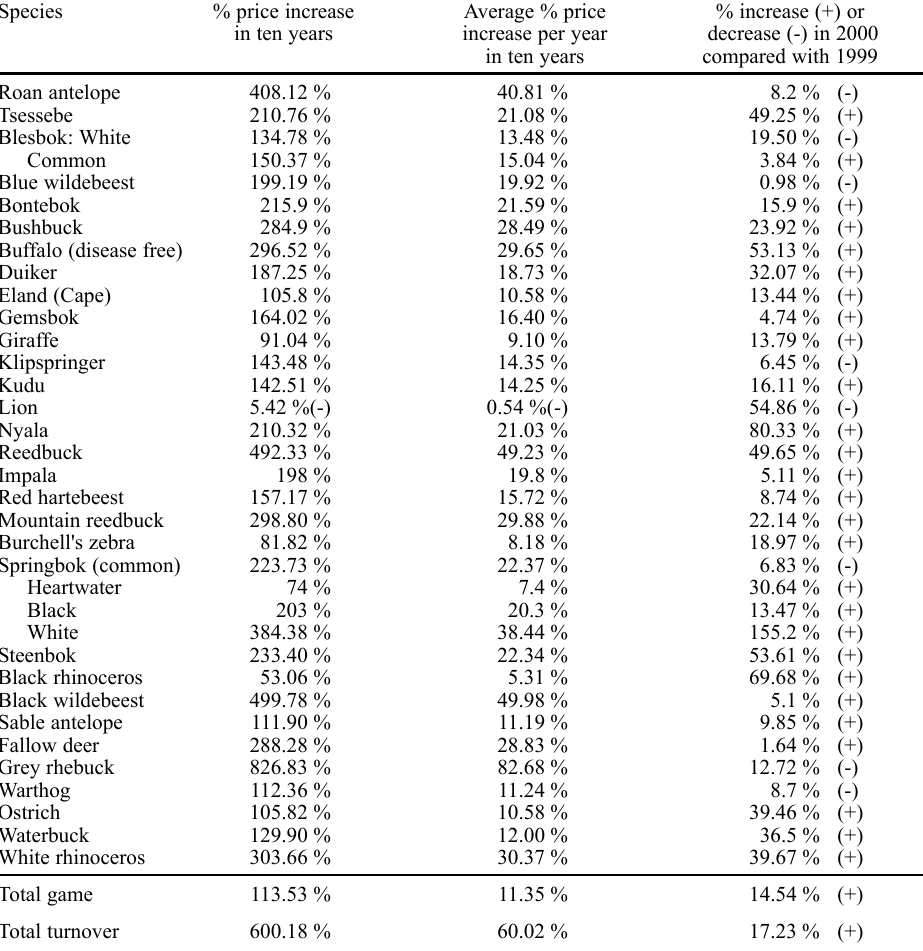
Table 3 Percentage price increase (+) or decrease (-) in average auctioned game prices over the past ten years Species % price increase Average % price % increase (+) or in ten years increase per year decrease (-) in 2000 in ten